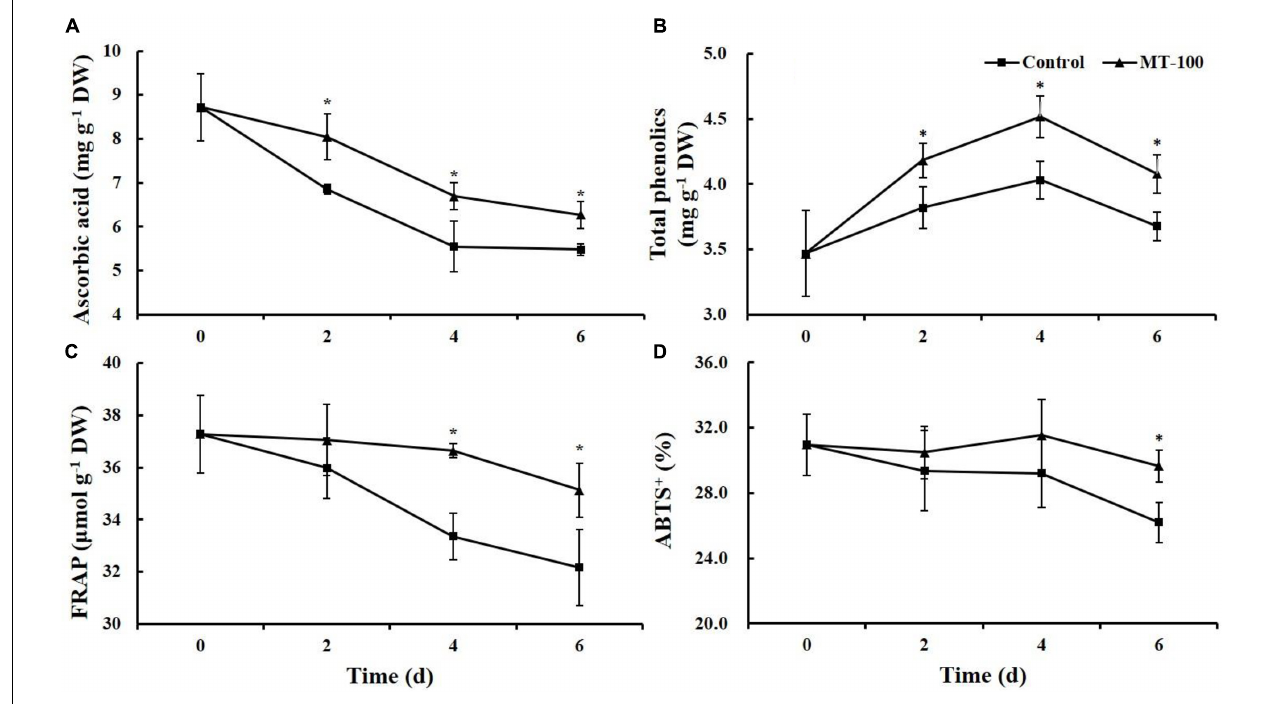
FIGURE 4 | Main antioxidants content and antioxidant capacity levels of 100 µ mol L − 1 melatonin treated lateral buds of baby mustard during storage at 20 ◦ C. (A) Ascorbic acid; (B) total phenolics; (C) FRAP; (D) ABTS + . MT-100, 100 µ mol L − 1 melatonin treatment. Each value is presented as the mean ± standard error of four biological replicates. Asterisks (*) indicate the significant differences ( P < 0.05) between control and melatonin-treated lateral buds during